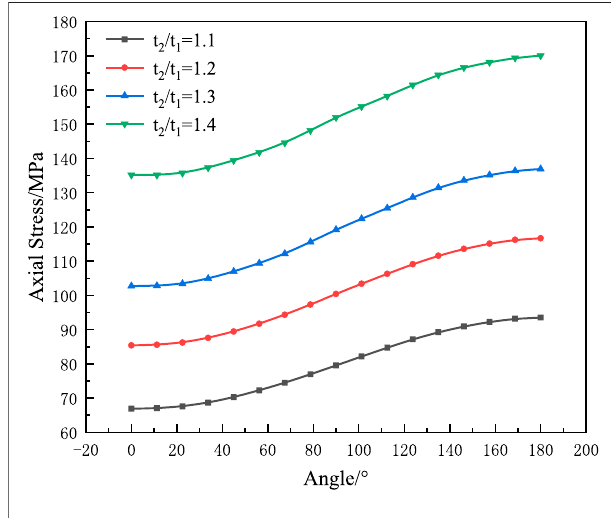
FIGURE 8 | Wall thickness ratio